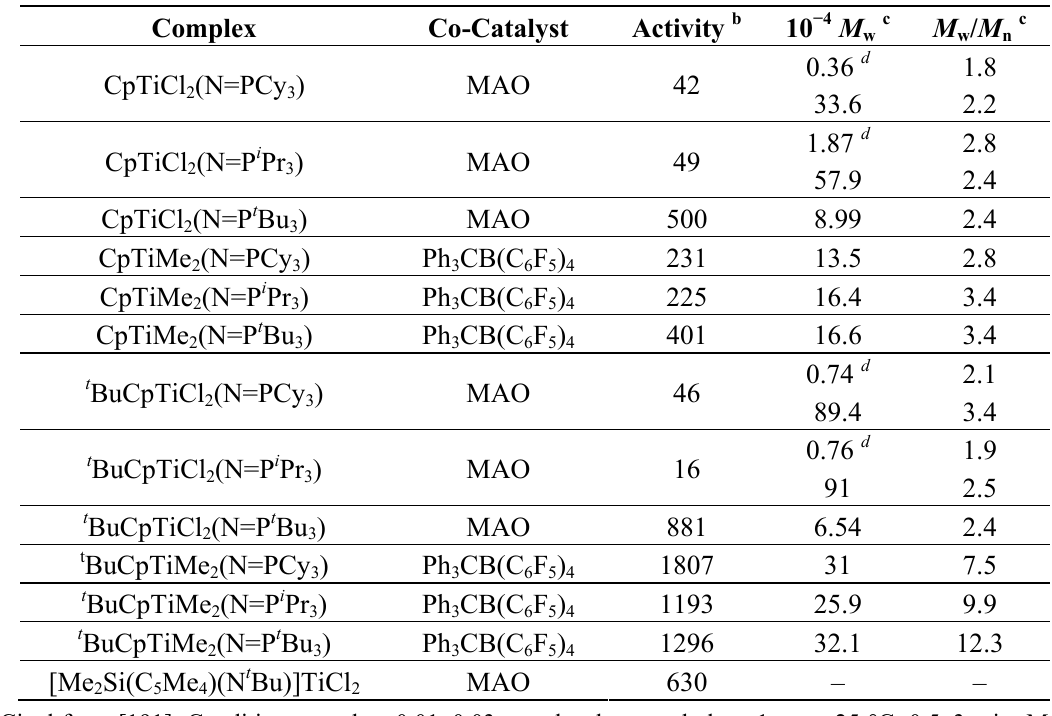
Table 5. Ethylene polymerization by Cp'TiX X = Cl, Me; R = Cy, i Pr, t Bu]–co-catalyst systems a , reprinted with permissions form [186,193]. Copyright 2011 2013 RSC.